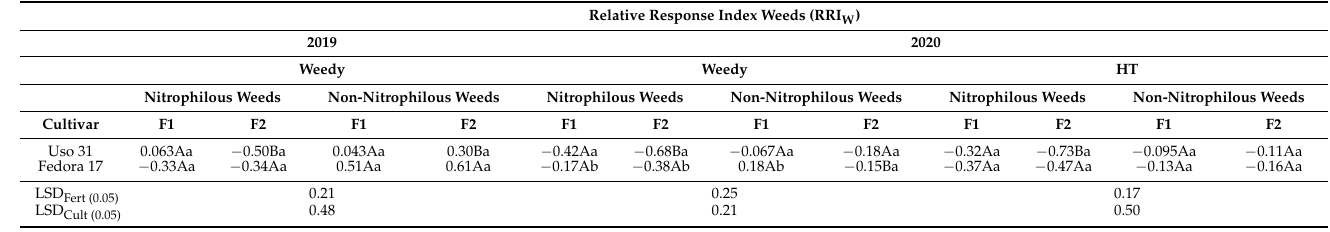
Table 6. The effect of interaction of cultivar × fertilization × weed management on the relative response index of nitrophilous and non-nitrophilous weeds across the two growing seasons 2019 and 2020. WM: weed management treatments (weed-free; weedy; HT: herbicide-treated); C: cultivars (Uso 31; Fedora 17); F: fertilization treatments (F1: 70 kg ha − 1 ; F2: 140 kg ha − 1 ).